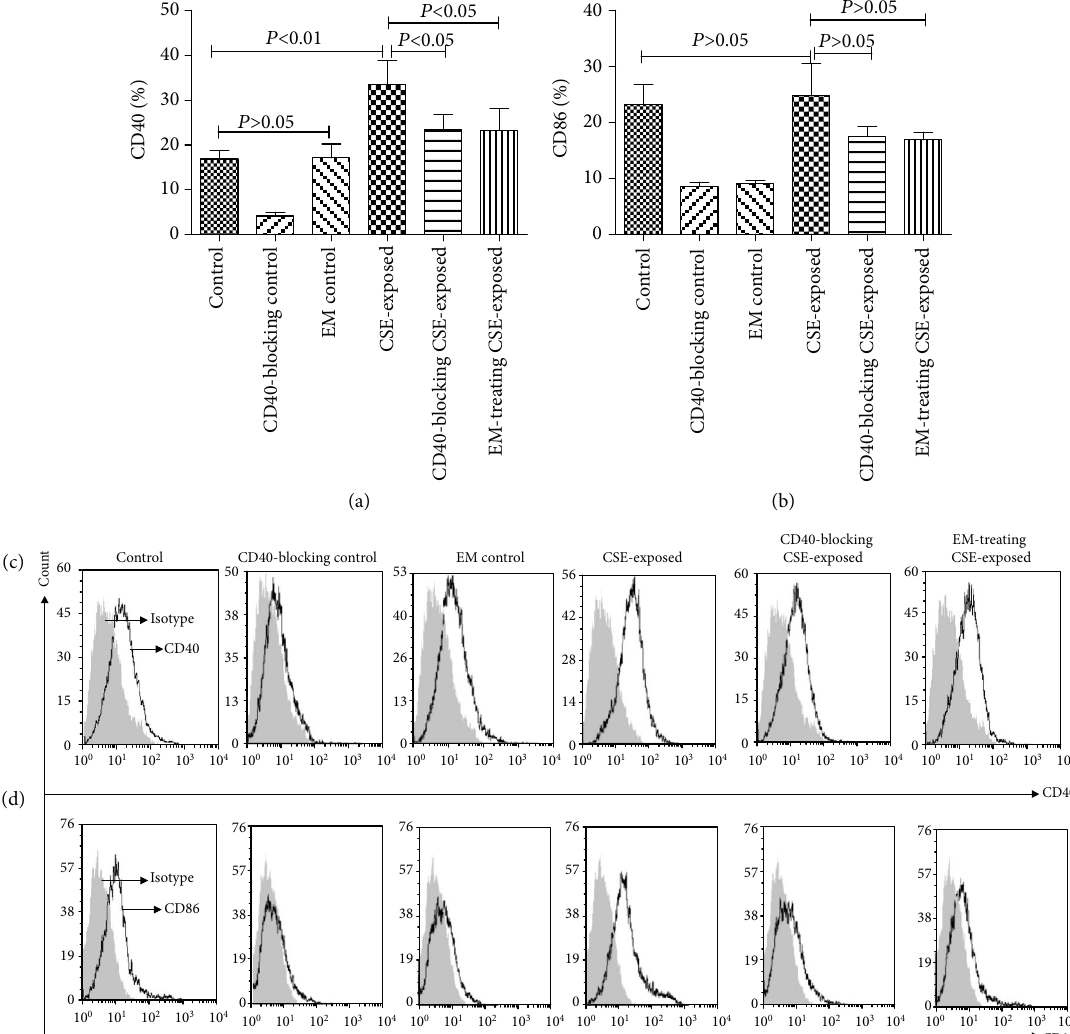
Figure 1: E ff ects of CSE and EM on the expression of costimulatory molecules (CD40 and CD86) in DCs. (a, c) E ff ects of CSE and EM on CD40 expression ( n = 6 ). (b, d) E ff ects of CSE and EM on CD86 expression ( n = 6 ). (The height of the bar chart represents the mean and the height of the error line indicates the standard errors of the means in the